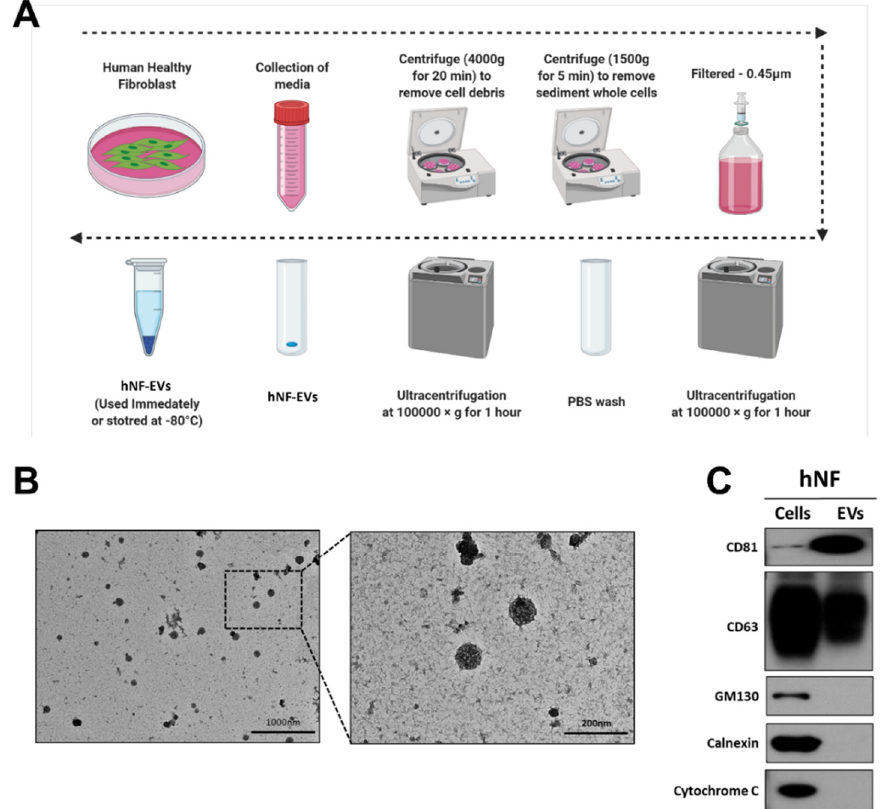
Figure 2. Isolation and characterization of human normal fibroblast derived extracellular vesicles (hNF-EVs). ( A ) Schematic diagram of the isolation protocol of EVs from hNF cells, created with BioRender.com (accessed on 11 August 2021). ( B ) Transmission electron microscopy of hNF-EVs; scale bar: 1000 nm and 200 nm. ( C ) Western blot (WB) analysis of hNF cells and hNF-EVs, probed with CD81, CD63, GM130, calnexin, and cytochrome C antibodies.